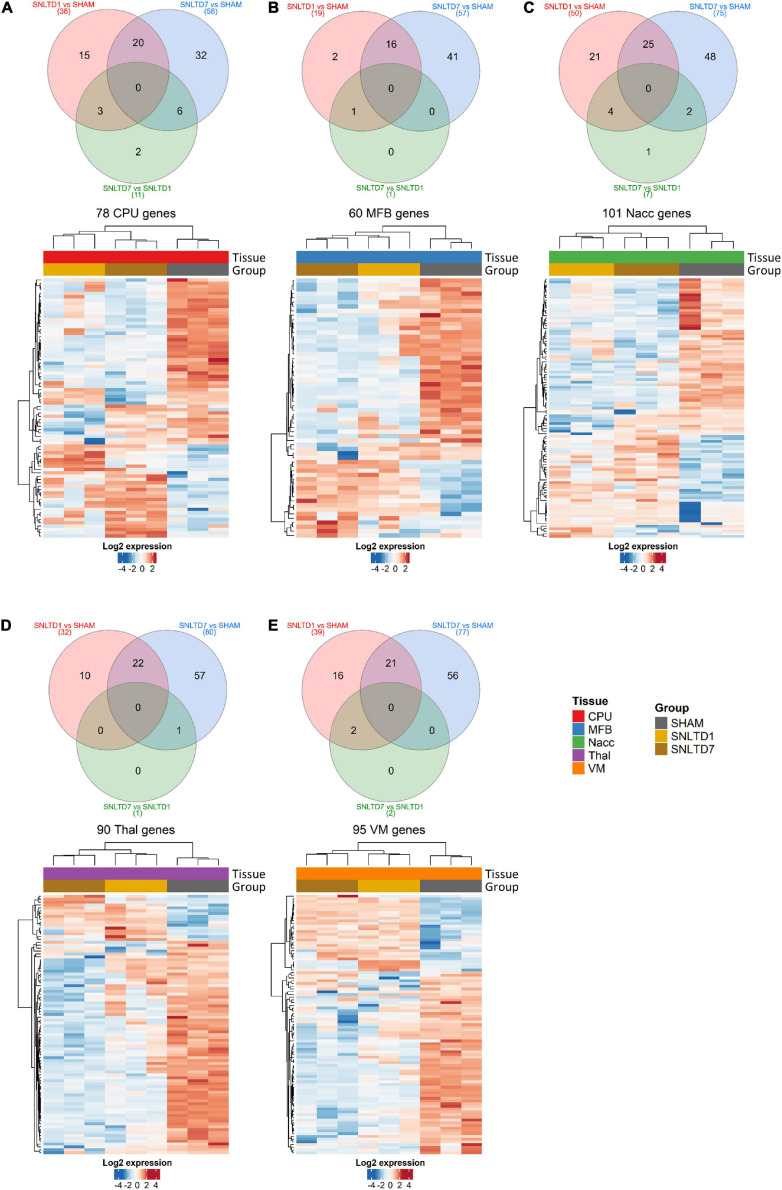
Differential-expression analysis. (A–E) Venn diagrams and heatmaps showing deregulated proteins in CPu, MFB, NAcc, Thal, and VM, respectively. In the heatmaps, red and blue colors represent high and low expression levels, respectively. Protein expression was centered and scaled prior to clustering. Hierarchical clustering was done using Euclidean distance with average linkage for samples, whereas Pearson correlation was used with average linkage for proteins.